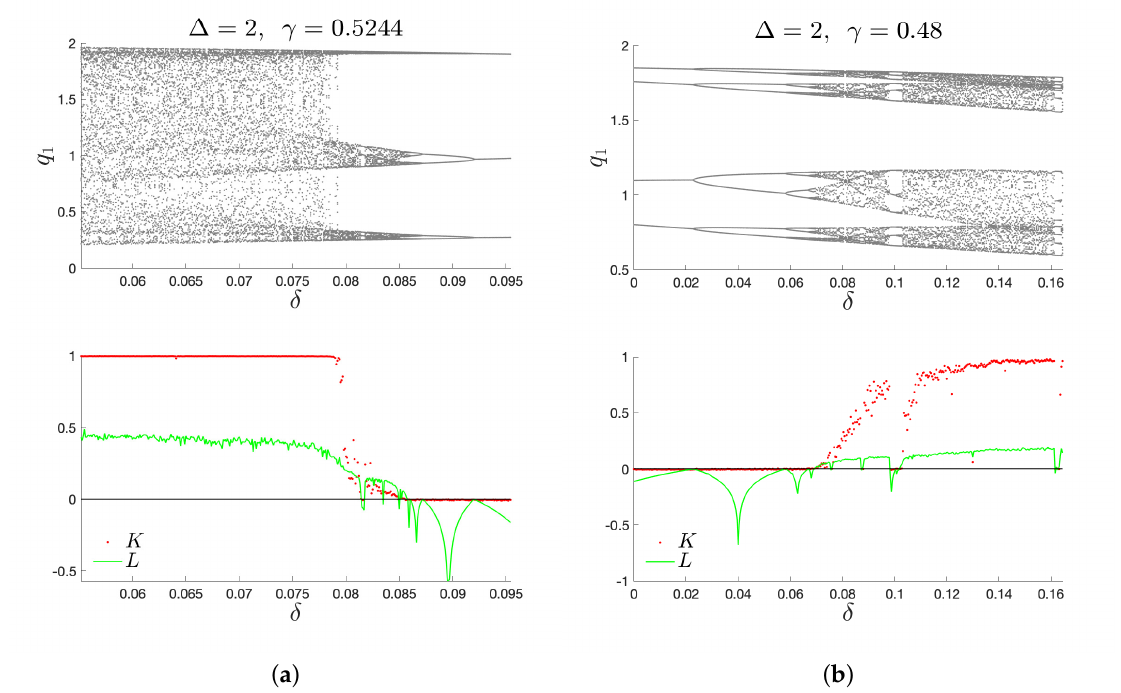
Figure 8. BD δ of IHCOM Equation (11) ( upper ) and K , L ( lower ) with ∆ = 2 and ( a ) γ = 0.5244: ( b ) γ =